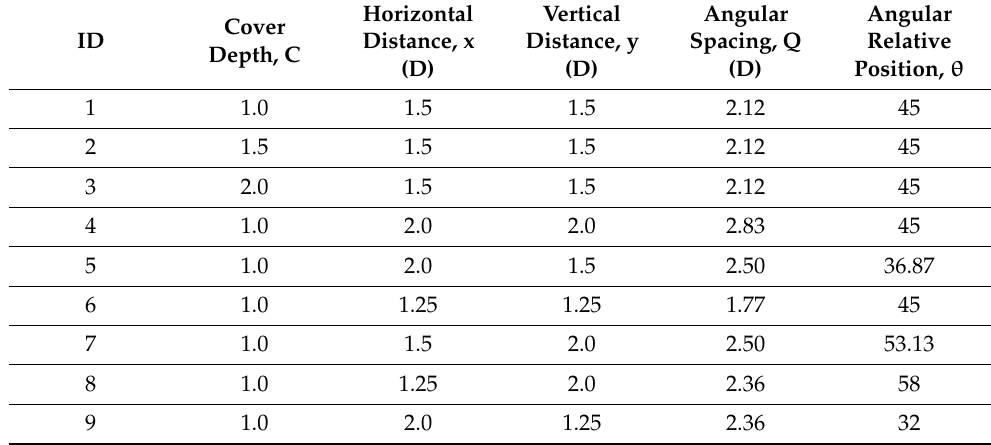
Table 1. Geometries of twin tunnels used in the finite element